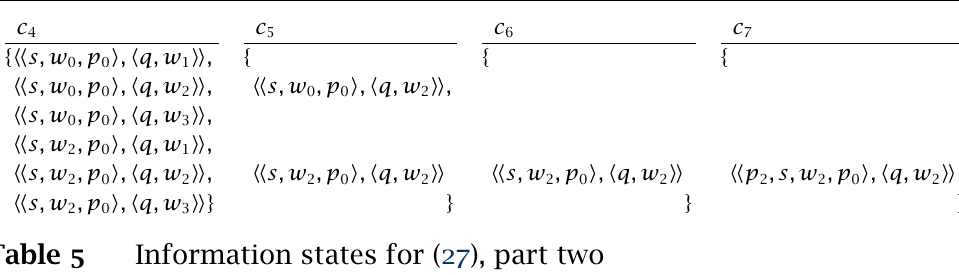
Information states for ( 27 ), part